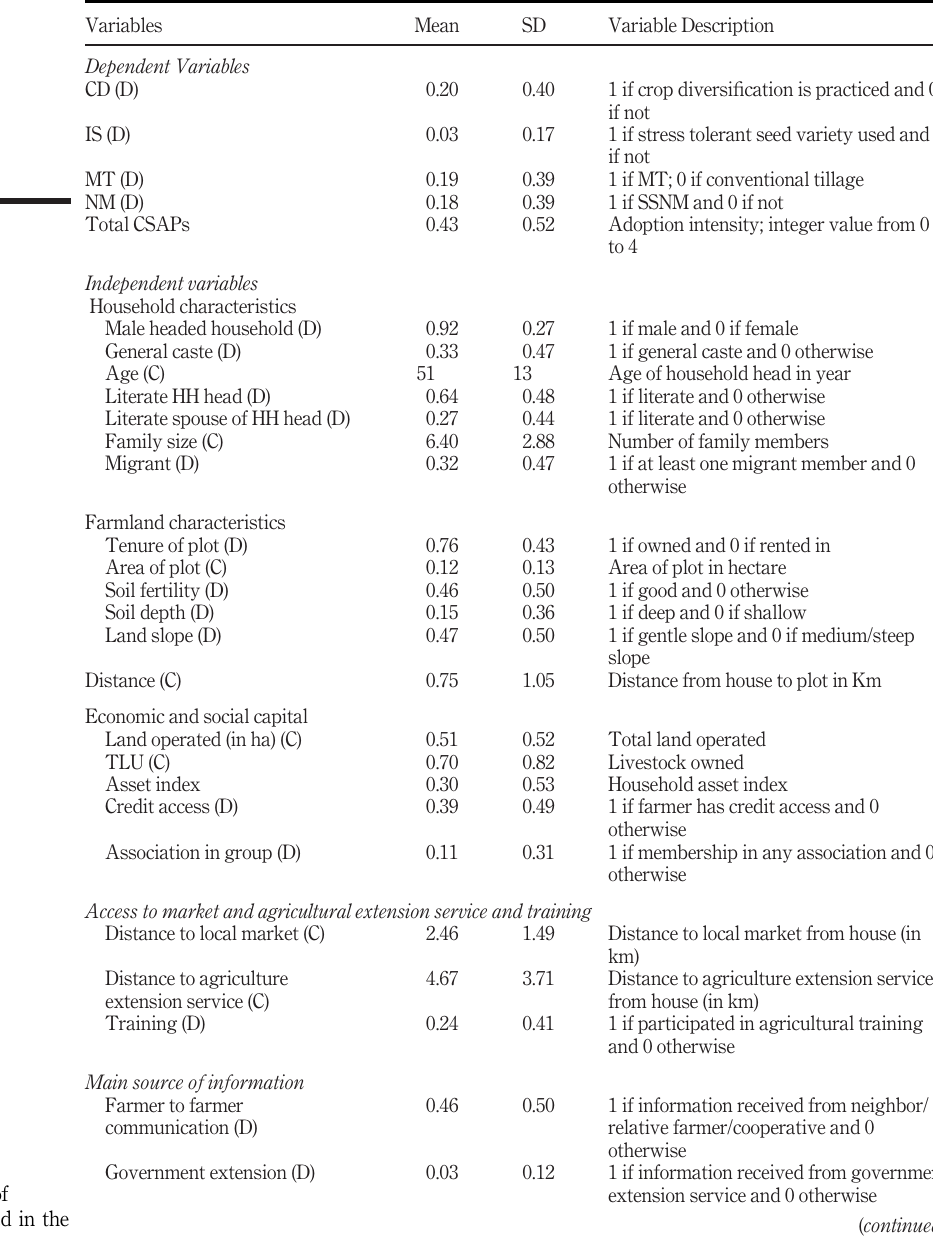
Table II. Description of variables used in the